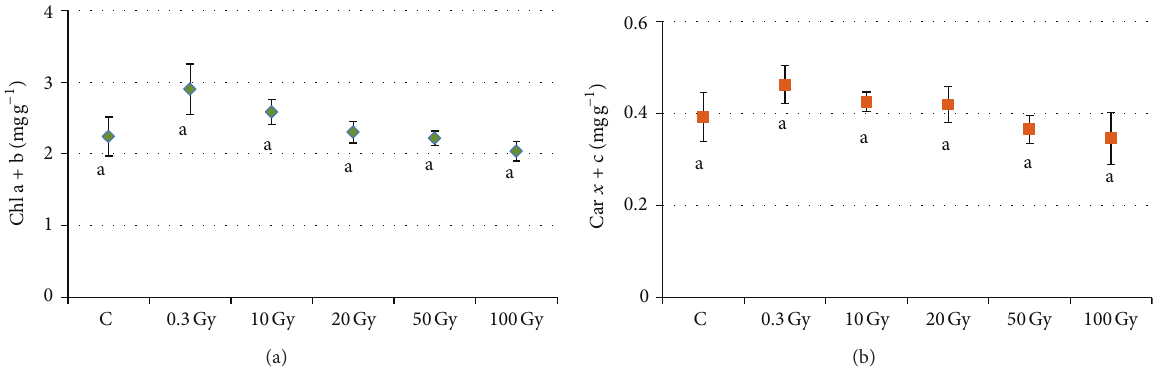
Figure7: Total chlorophyll content (Chla+b)(a)and totalcarotenoid content (Carx+c)(b),in compound (CL) S. lycopersicum L. “Microtom” leaves of control and plants from seeds irradiated at different doses of X-rays. Mean values and standard errors are shown ( 𝑛 = 5 ). Different letters correspond to significantly different values according to multiple comparison tests ( 𝑃 < 0.05